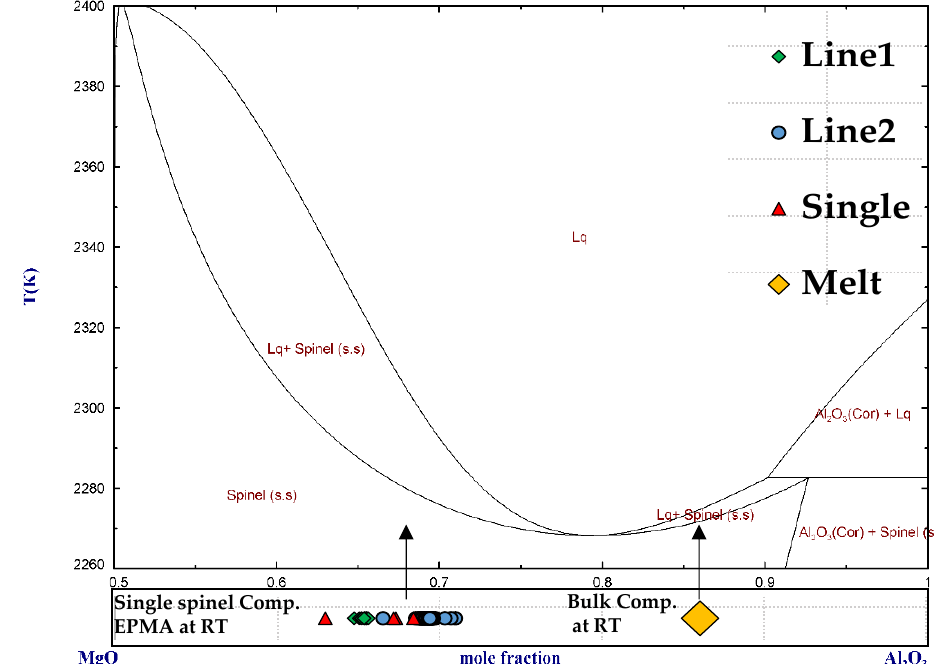
Figure 6. The calculated MgO-Al 2 O 3 phase diagram at 1 atm total based on [22]. Lq, Liquid; spinel (s.s), spinel solid solution; Al 2 O 3 (Cor), corundum. In this diagram, the composition of the initial melt and the composition of different spinel grains from two line scans and several single spot measurements, analyzed at room temperature (RT), are presented. The composition of the initial melt is the starting point of the spinel crystallization.